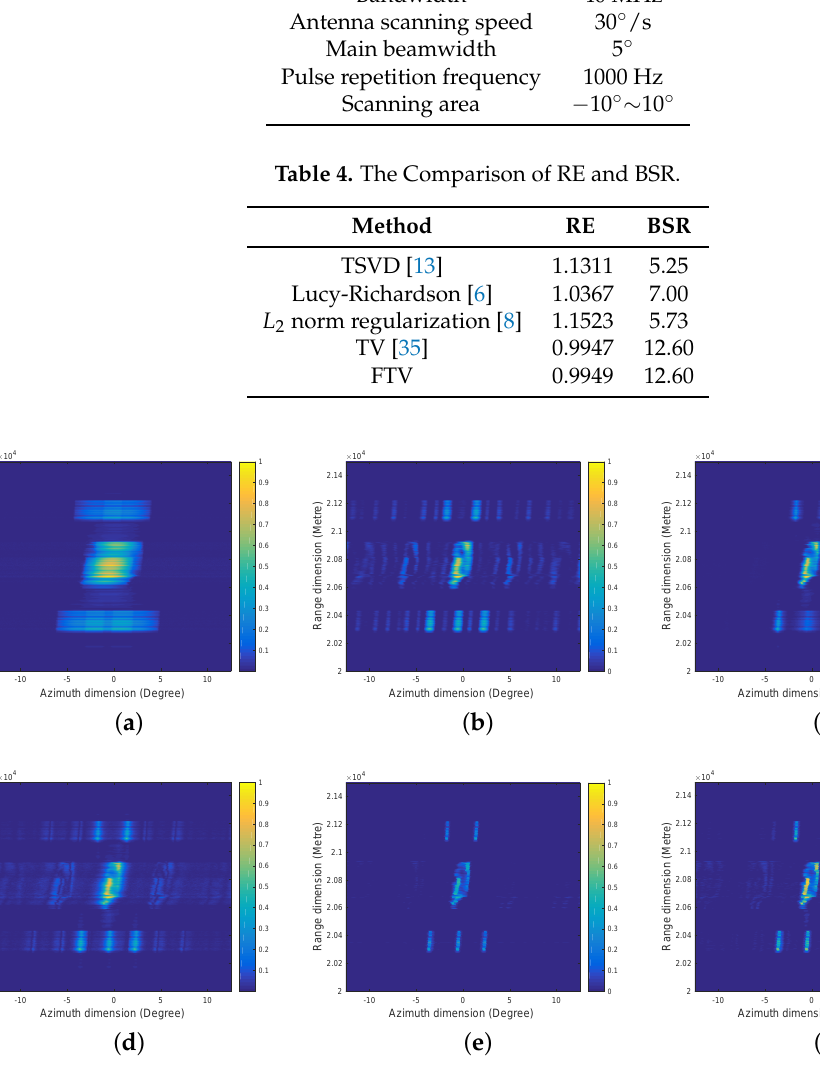
Figure 4. The 2-D simulation result. ( a ) The echo; ( b ) The truncated singular value decomposition (TSVD) method; ( c ) The Lucy-Richardson method; ( d ) The L 2 norm regularization method; ( e ) The total variation (TV) method; ( f ) The proposed fast total variation (FTV)